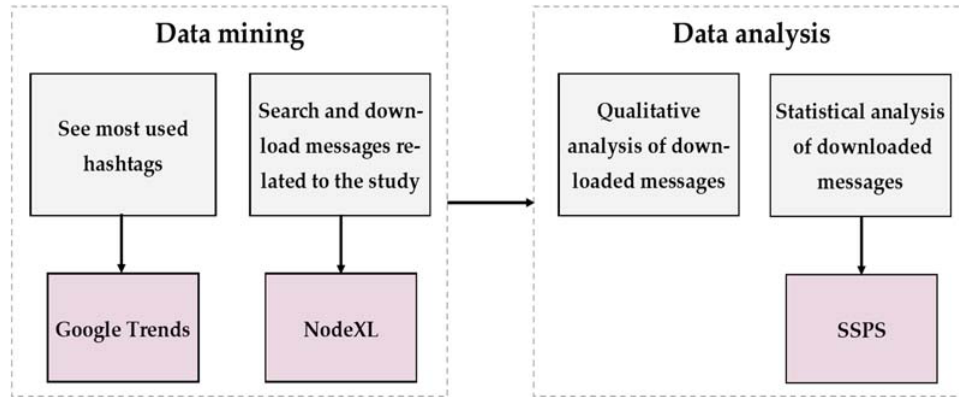
Figure 1. Data mining and analysis scheme.